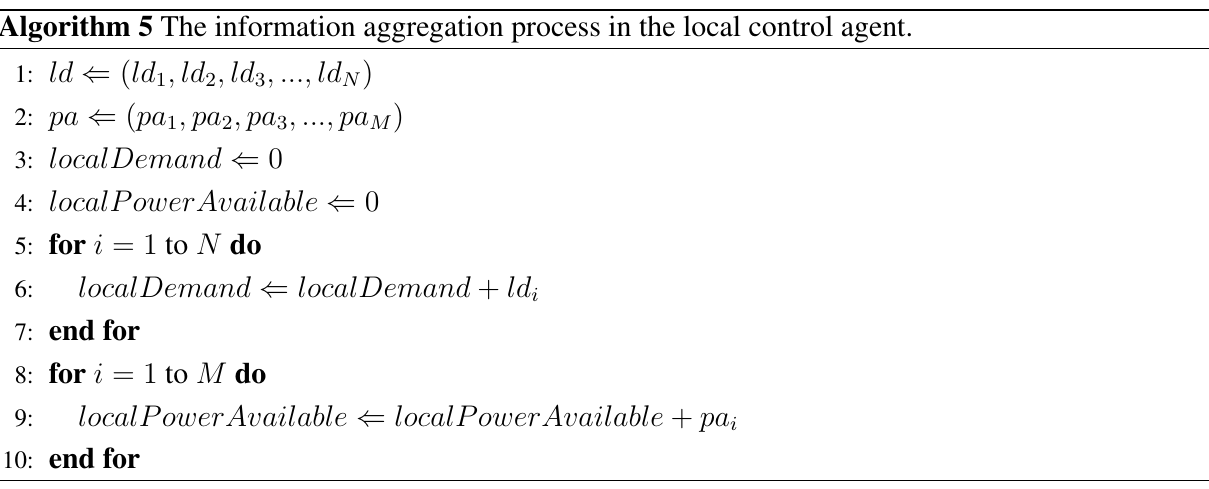
Algorithm 5 The information aggregation process in the local control